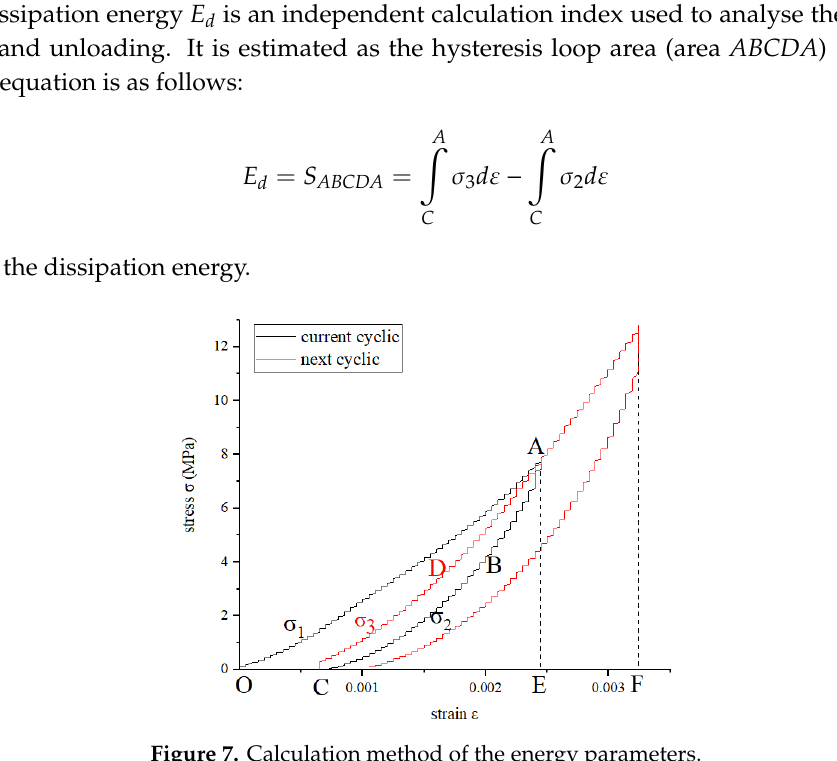
Figure 7. Calculation method of the energy parameters.